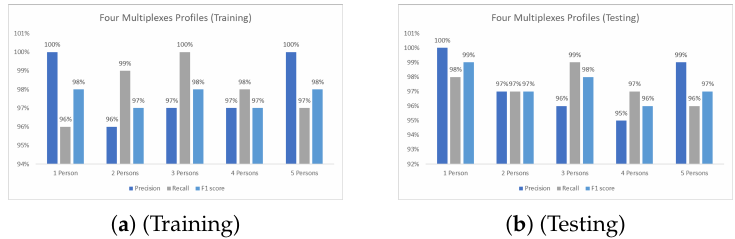
Figure 26. TAWSEEM: precision, recall and F1 score (four multiplexes